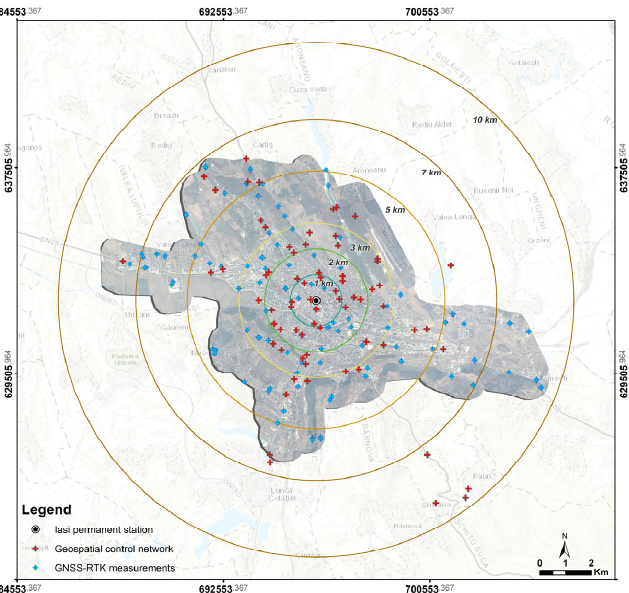
Figure 10. GNSS measurements for GCPs and ChPs (blue) and leveling points (red).